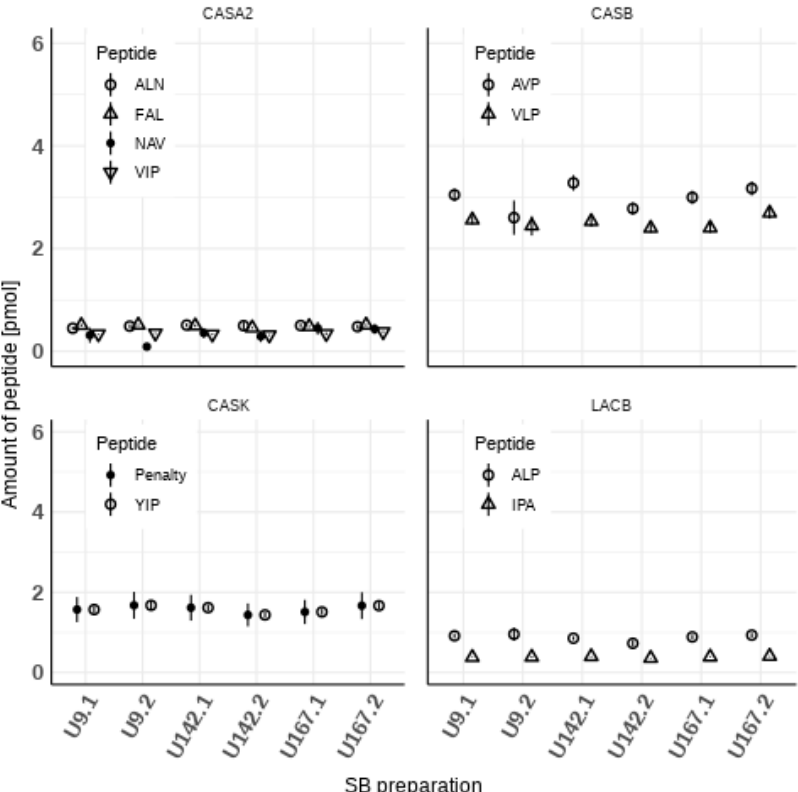
Figure 2. Measured amounts of peptides sorted by the respective protein (CASA2, CASB, CASK, and LACB) in the six SBs (index k = 1 to 6, left to right); symbols depict the quantity values of the respective peptides, the vertical bars the associated expanded uncertainties (might be smaller than the symbol, expansion factor k = 2); for CASK, the penalty applied for the uncertainty of f P-P,j,k is also displayed.